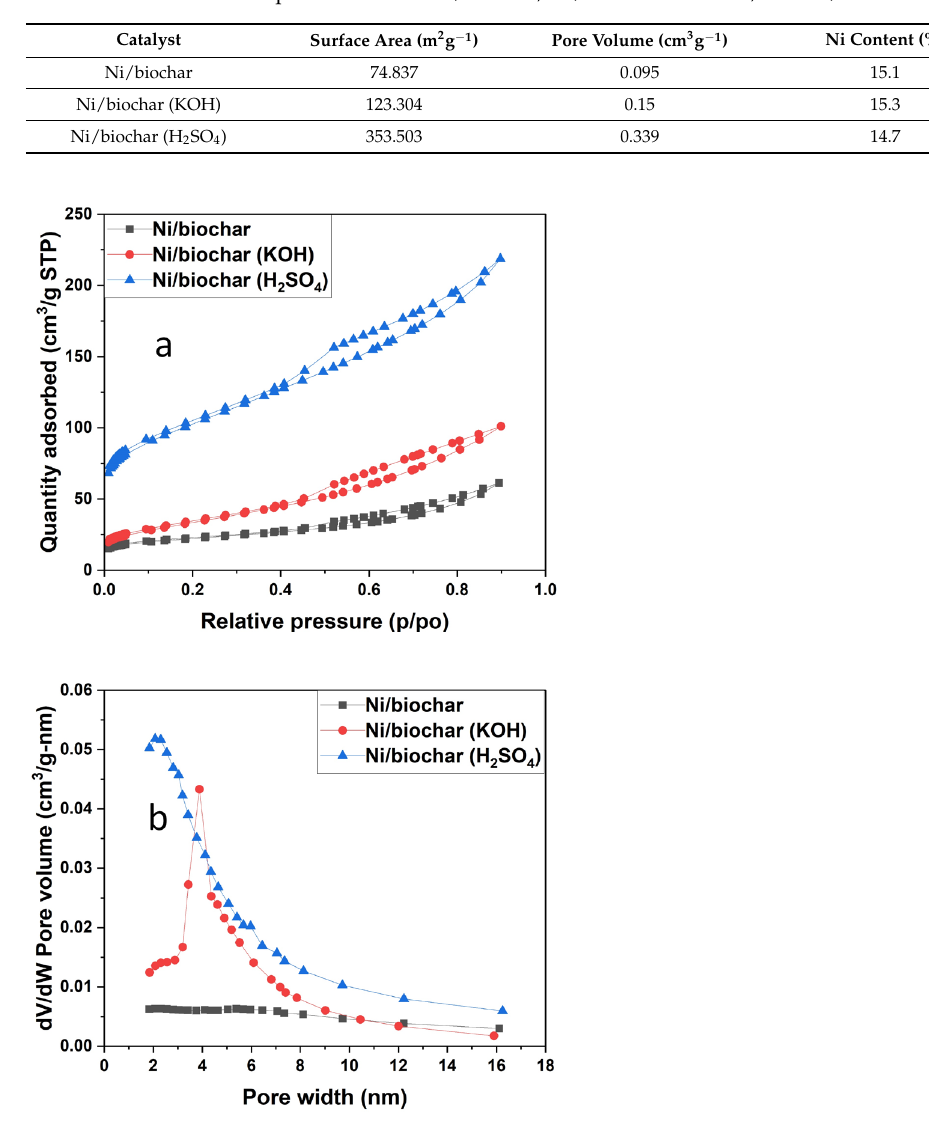
Figure 1. The ( a ) N 2 adsorption–desorption isotherm and ( b ) pore size distribution of the prepared catalysts. The pore size distribution of the catalysts further confirms that they are mesoporous materials, with a pore size distribution found mostly in the range between 2 nm and 16.24 nm (mesopore range 2 to 50 nm).